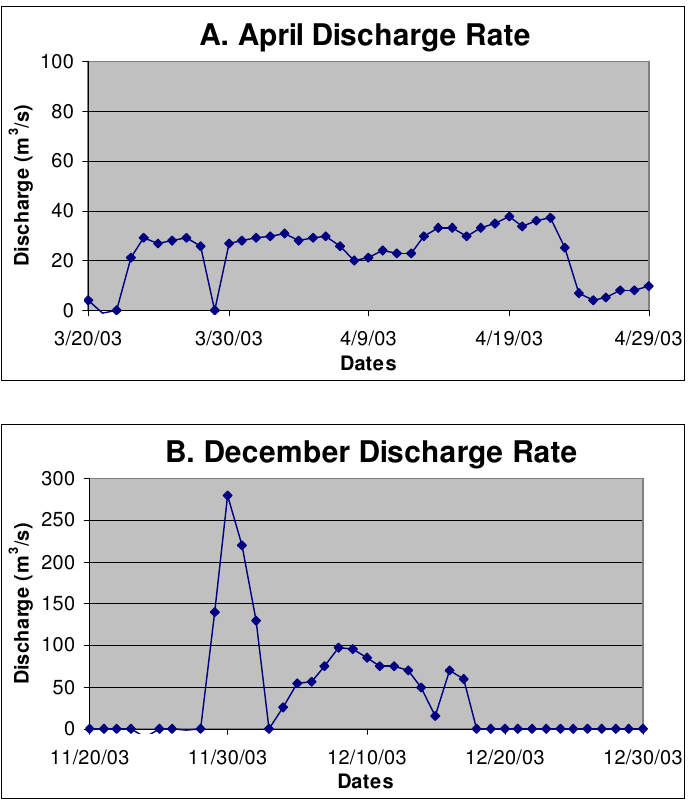
FIGURE 2. Discharge represents (A) medium pulse event (April) and (B) high pulse event